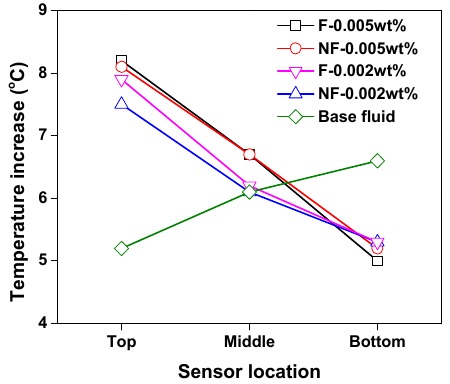
Figure 13. Variation of temperature increase of MWCNT nanofluid according to sensor location.